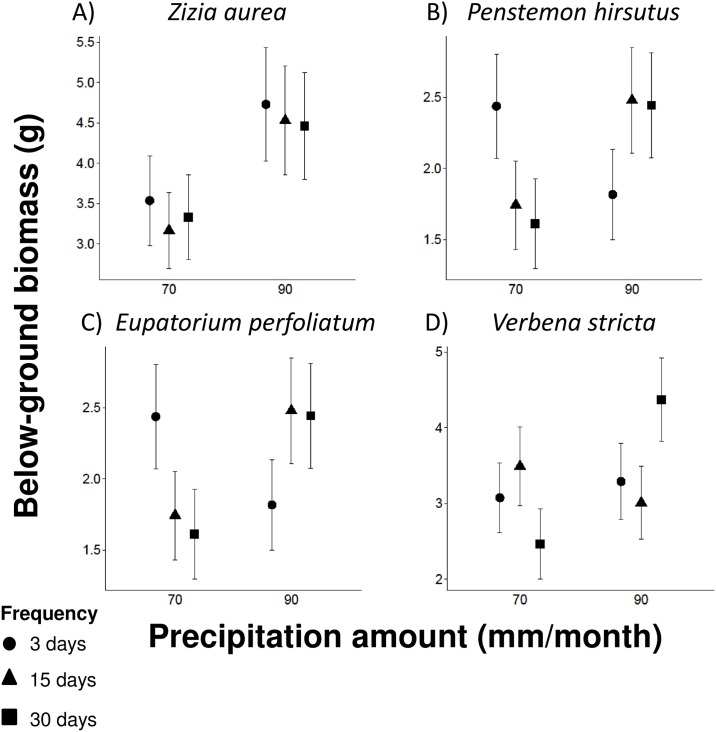
Below-ground biomass in response to precipitation amount and frequency.The effects of precipitation amount and frequency on below-ground biomass. There was a significant effect of precipitation amount on (A) Zizia aurea. Precipitation amount and frequency interacted to affect: (B) Penstemon hirsutus, (C) Eupatorium perfoliatum, and (D) Verbena stricta (see Table 1). Points show least-squares mean values and whiskers denote ± 1 SE around the mean.